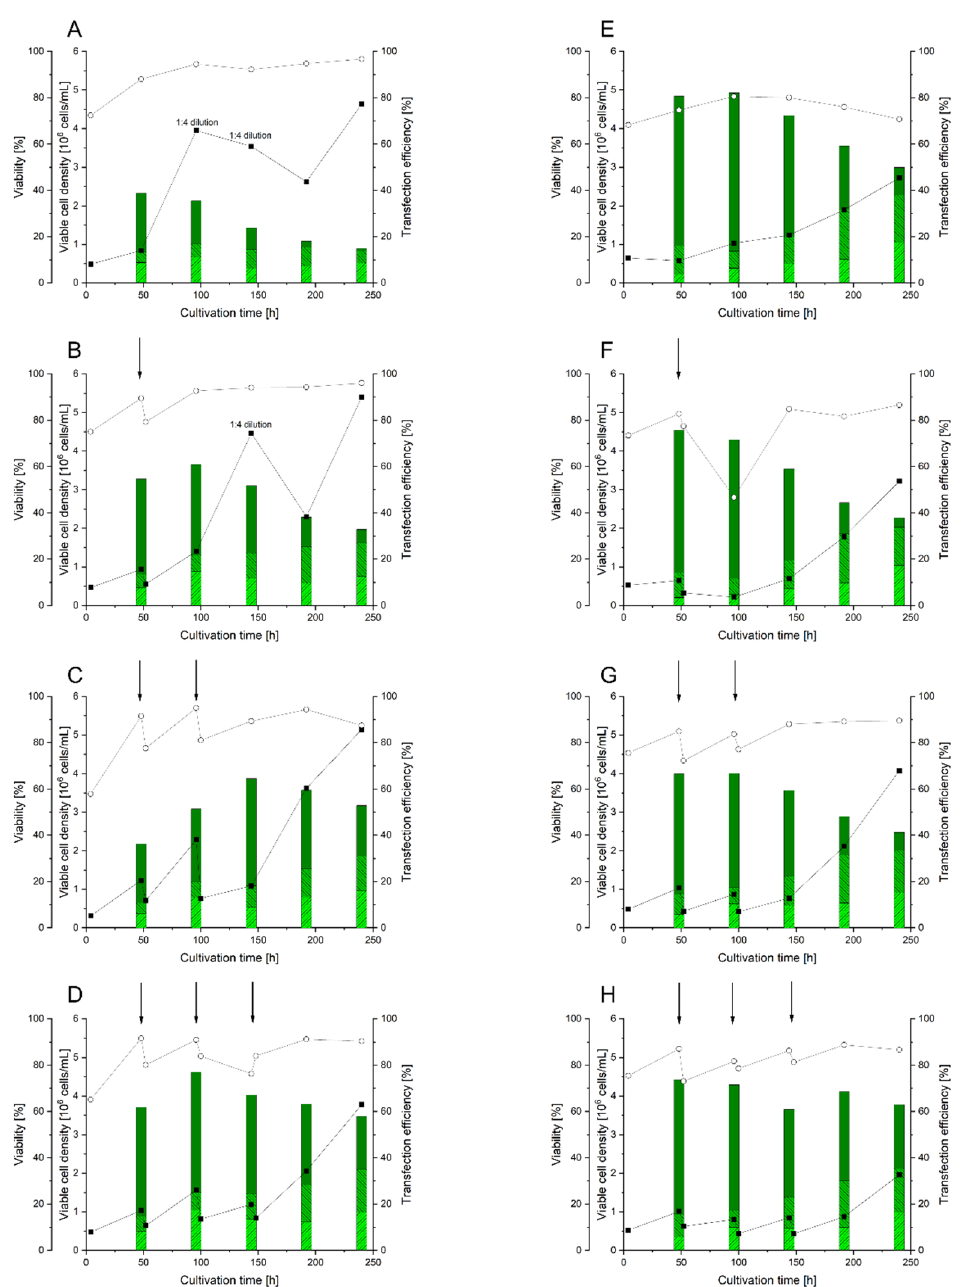
Figure 3. RTT of HEK sus cells using pEGFP-N1 in two independent biological replicates (n = 2) referred to as ( A – D , E – H ). Shown are the viable cell density ( ■ ) and viability ( ○ ). The TE (determined via EGFP expression) is shown by green bars, with light green representing the fraction of low pro- ducers, green representing that of middle producers, and dark green representing that of high pro- ducers. Arrows indicate the time points of repeated transfections. Whenever required (cell density > 3 × 10 6 cells/mL), the cells were further diluted (1:4) to prevent extensive nutrient depletion and metabolites accumulation. An exemplary analysis of the TE by flow cytometry is presented in Figure S4.